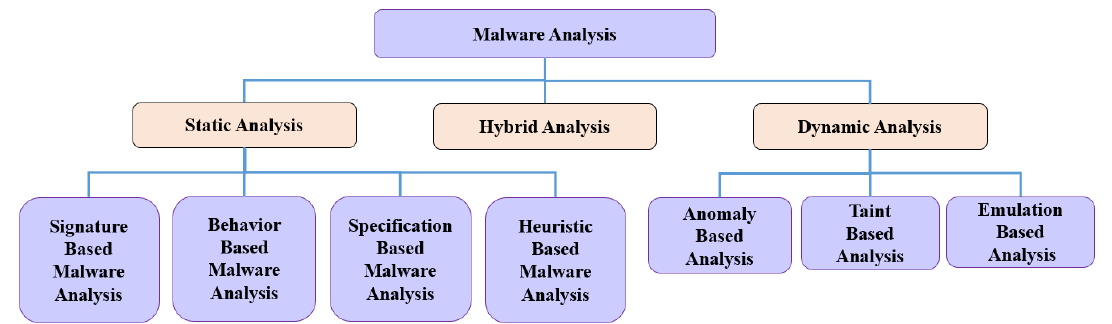
Figure 1. Existing Taxonomy of Malware Analysis.